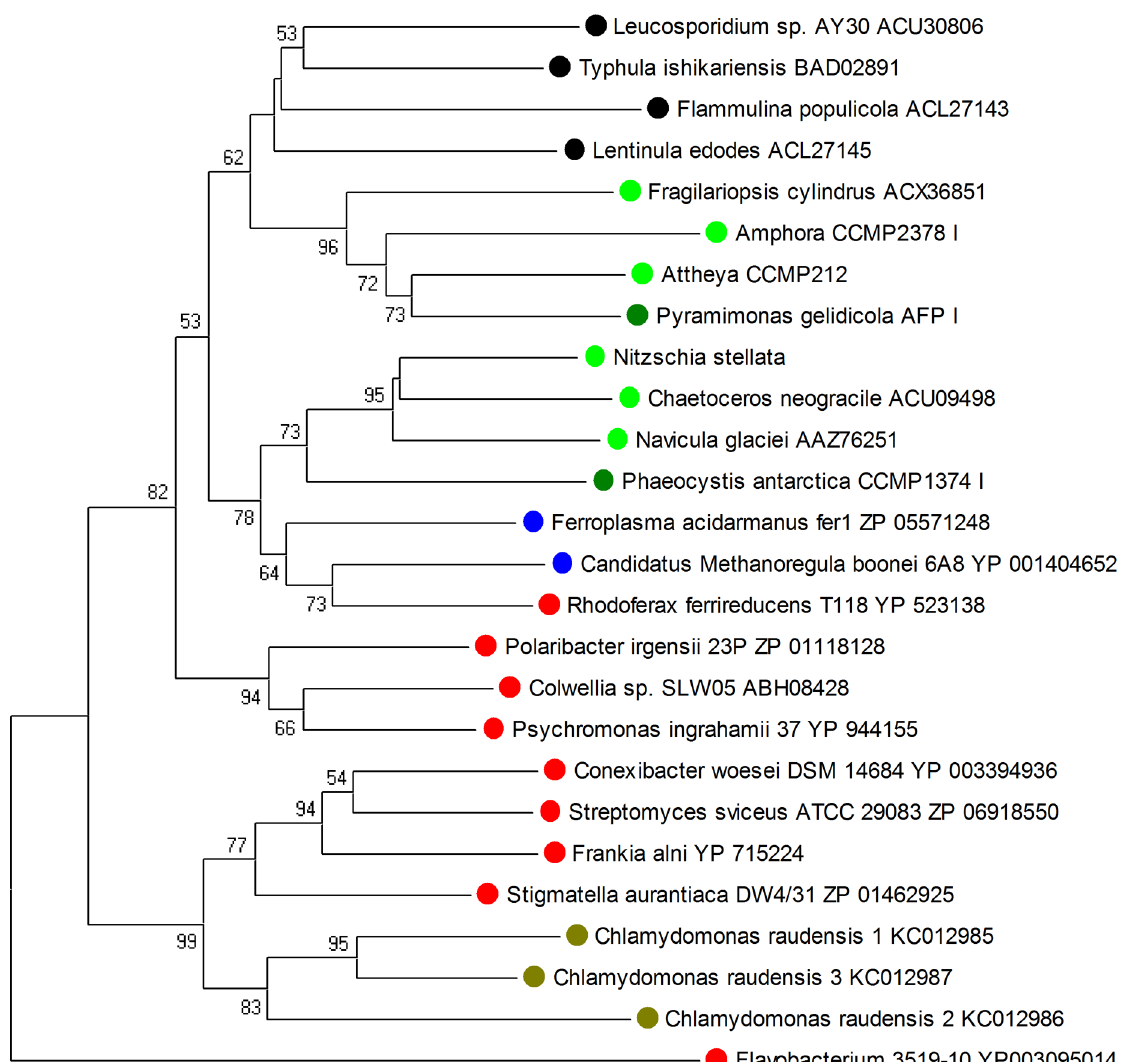
Figure 2. Neighbor-joining tree constructed from amino acid sequences of selected IBP and IBP-like proteins. The C. raudensis IBPs (olive) are closest to IBP-like proteins in several bacteria and relatively distant from other algal IBPs. All of the fungal and algal proteins have confirmed ice-binding activities. Among the archaeal and bacterial IBPs, only those of Colwellia and Flavobacterium 3519-10 have confirmed ice- binding activities. The tree was rooted with the Flavobacterium 3519-10 IBP. Numbers at nodes indicate bootstrap values for 500 replications. Values less than 50 are not shown. Colors: black, fungi; light green, diatoms; dark green prasinophyte and prymnesiophyte; blue, archaea; red, bacteria; olive, C. raudensis .